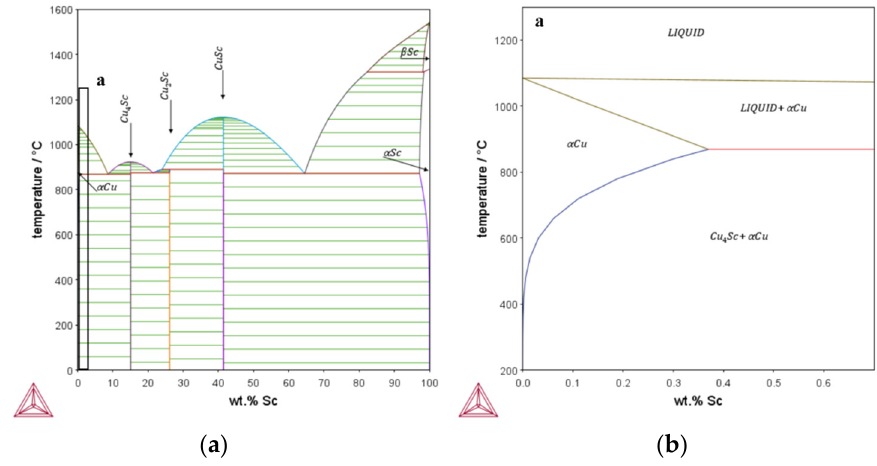
Figure A1. System Cu-Cr: ( a ) overall; ( b ) magnification of the copper-rich area (detail a).